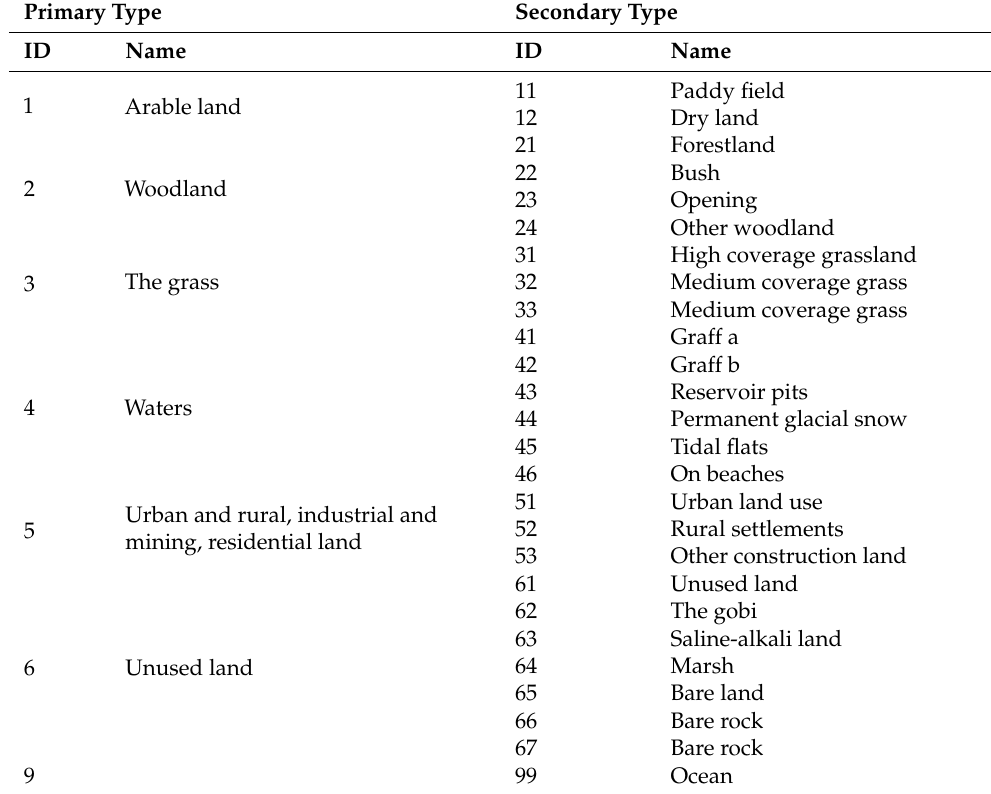
Table 1. The classification system of the remote-sensing monitoring data on land use status in